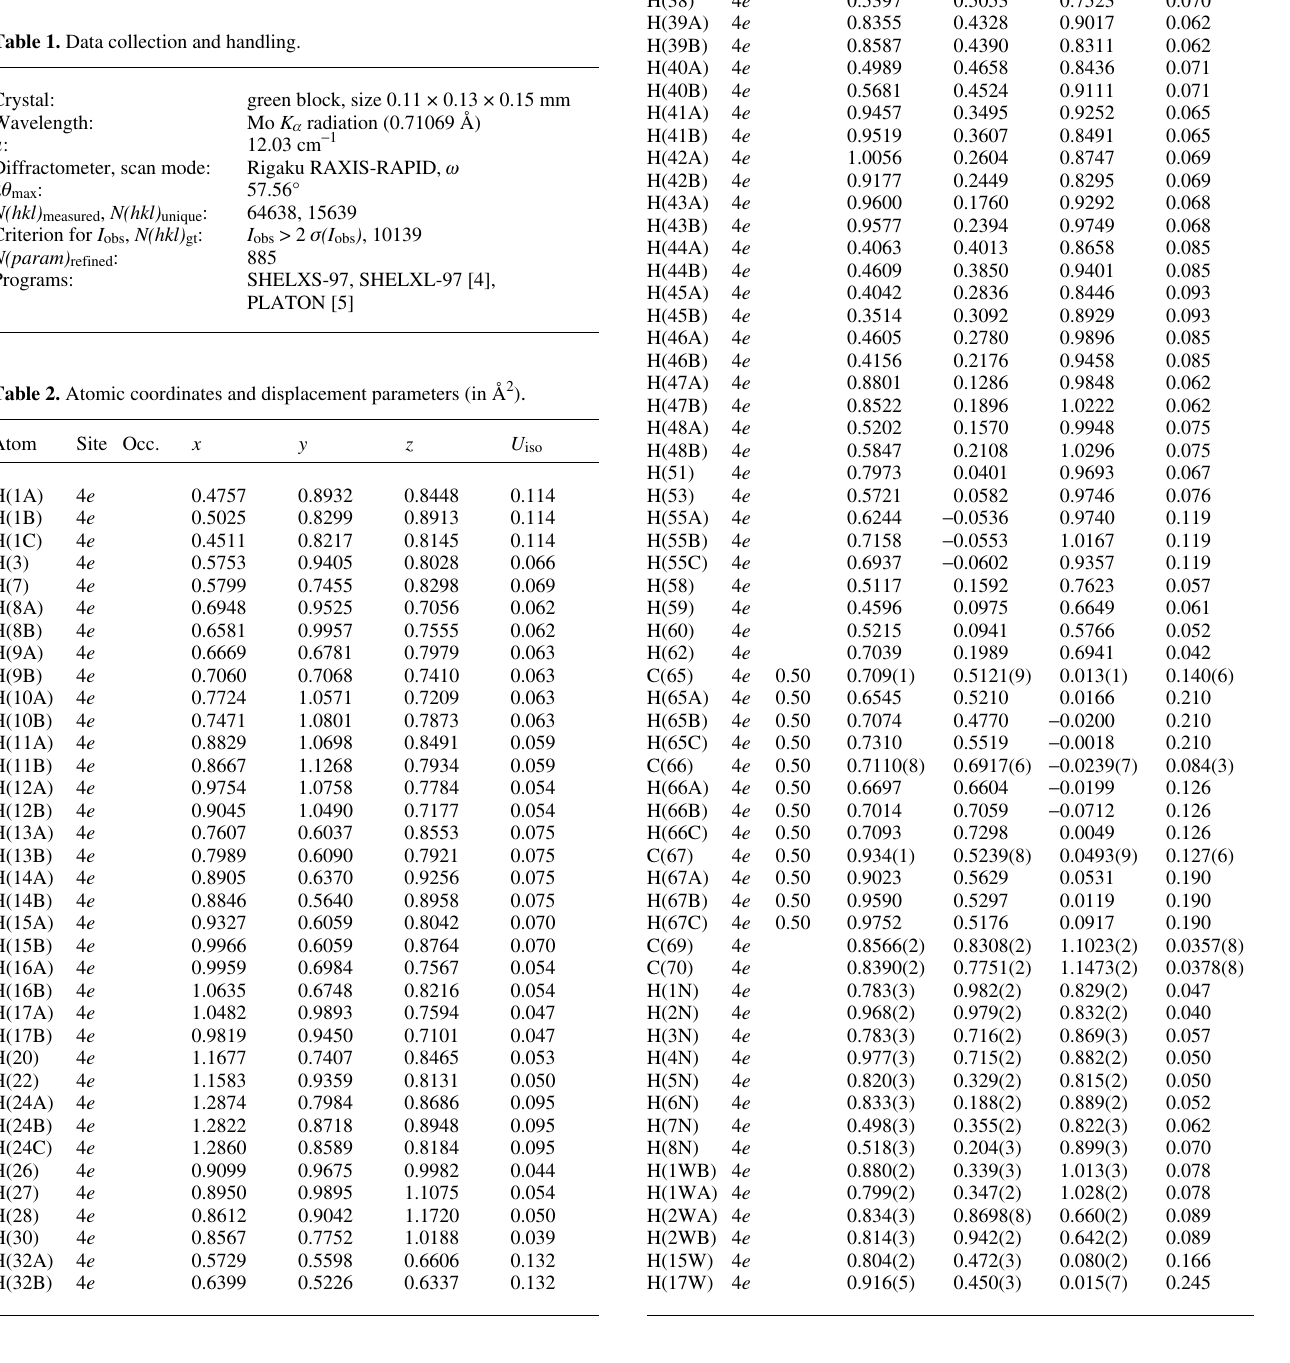
Table 3. Atomic coordinates and displacement parameters (in Å 2 ) .